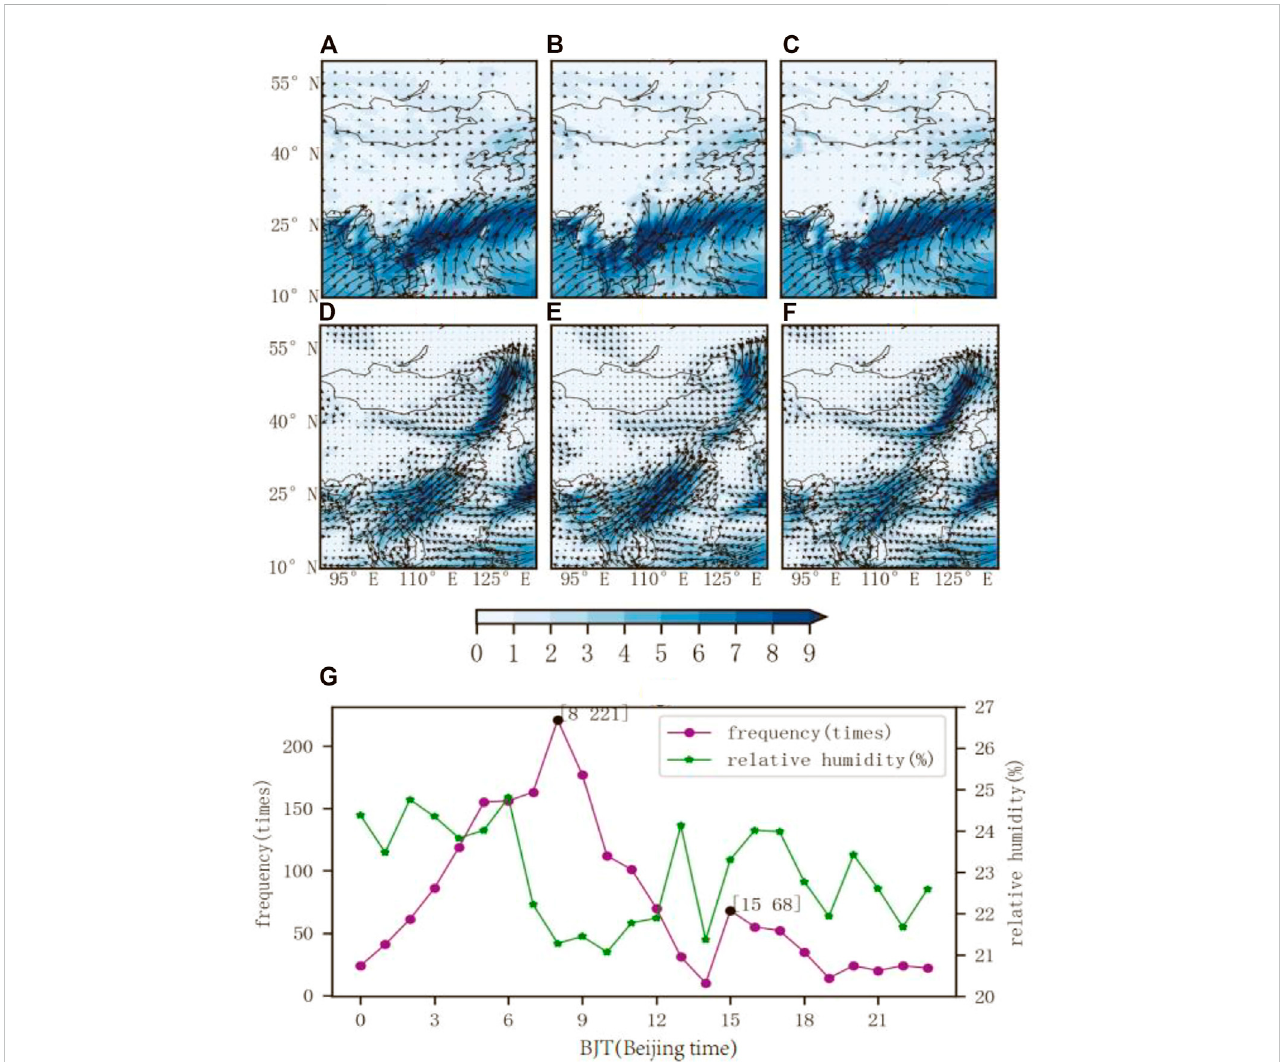
FIGURE 10 Diurnal variation of the single-layer water vapor fl ux fi eld at 850 hPa (unit: g · Pa − 1 · m − 1 · s − 1 ): (A) 0300 – 1000 BJT; (B) 1,100 – 1800 BJT; (C) 1900 – 0200 BJT. Diurnal variation of the water vapor fl ux fi eld of the whole layer of 1,000 – 300 hPa (unit: 2 · 10 2 · g · m − 1 · s − 1 ): (D) 0300 – 1000 BJT; (E) 1,100 – 1800BJT; (F) 1900 – 0200BJT. (G) Thenumberoftimestherelativehumidityislessthan30%duringdifferentdataobservations,andthecorresponding relative humidity value. The vector represents the water vapor fl ux